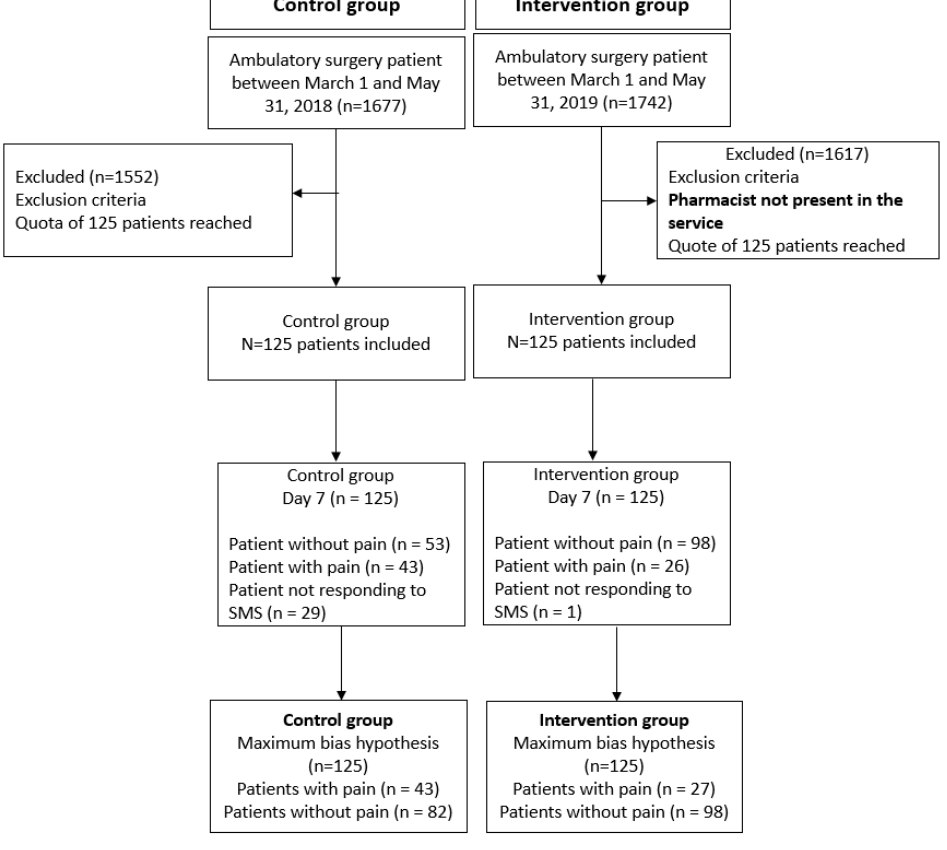
Figure 2. Flowchart. Figure 2.